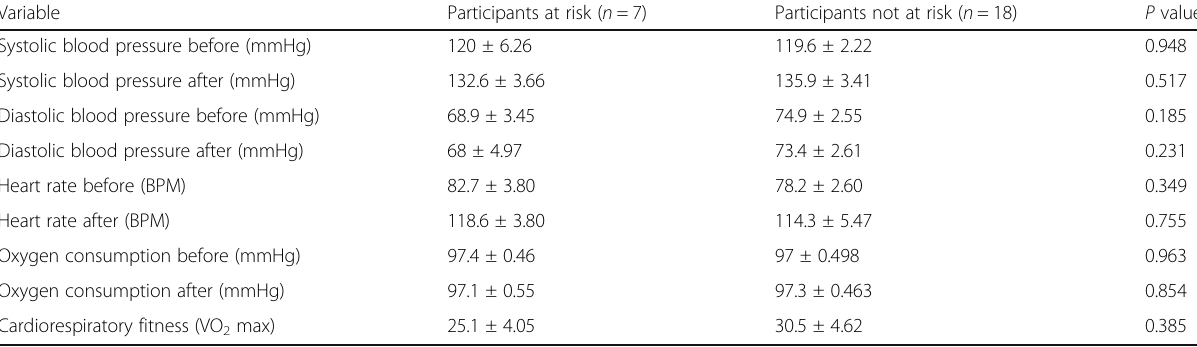
Table 3 Cardiorespiratory data of both groups (participants at risk and those not at risk) Variable